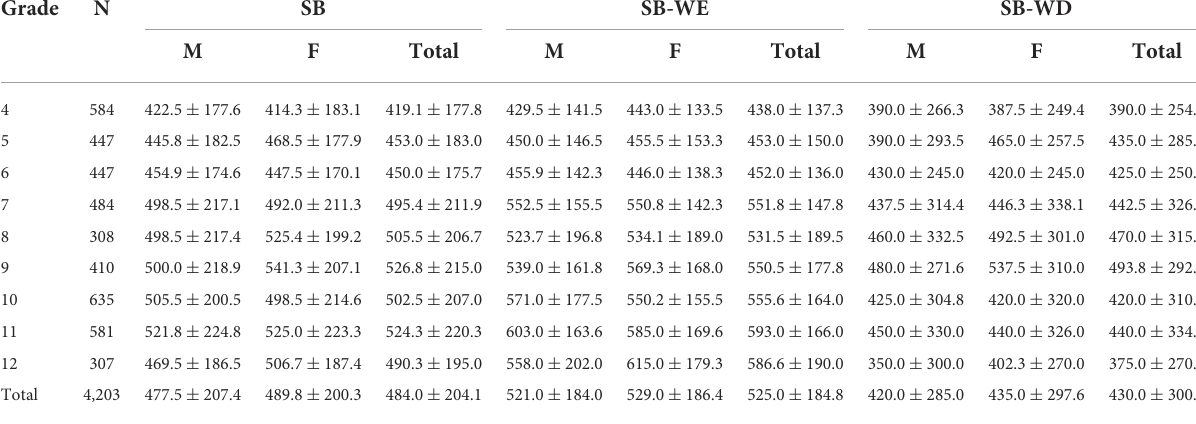
TABLE 2 Sedentary time of Chinese children and adolescents (min/d).